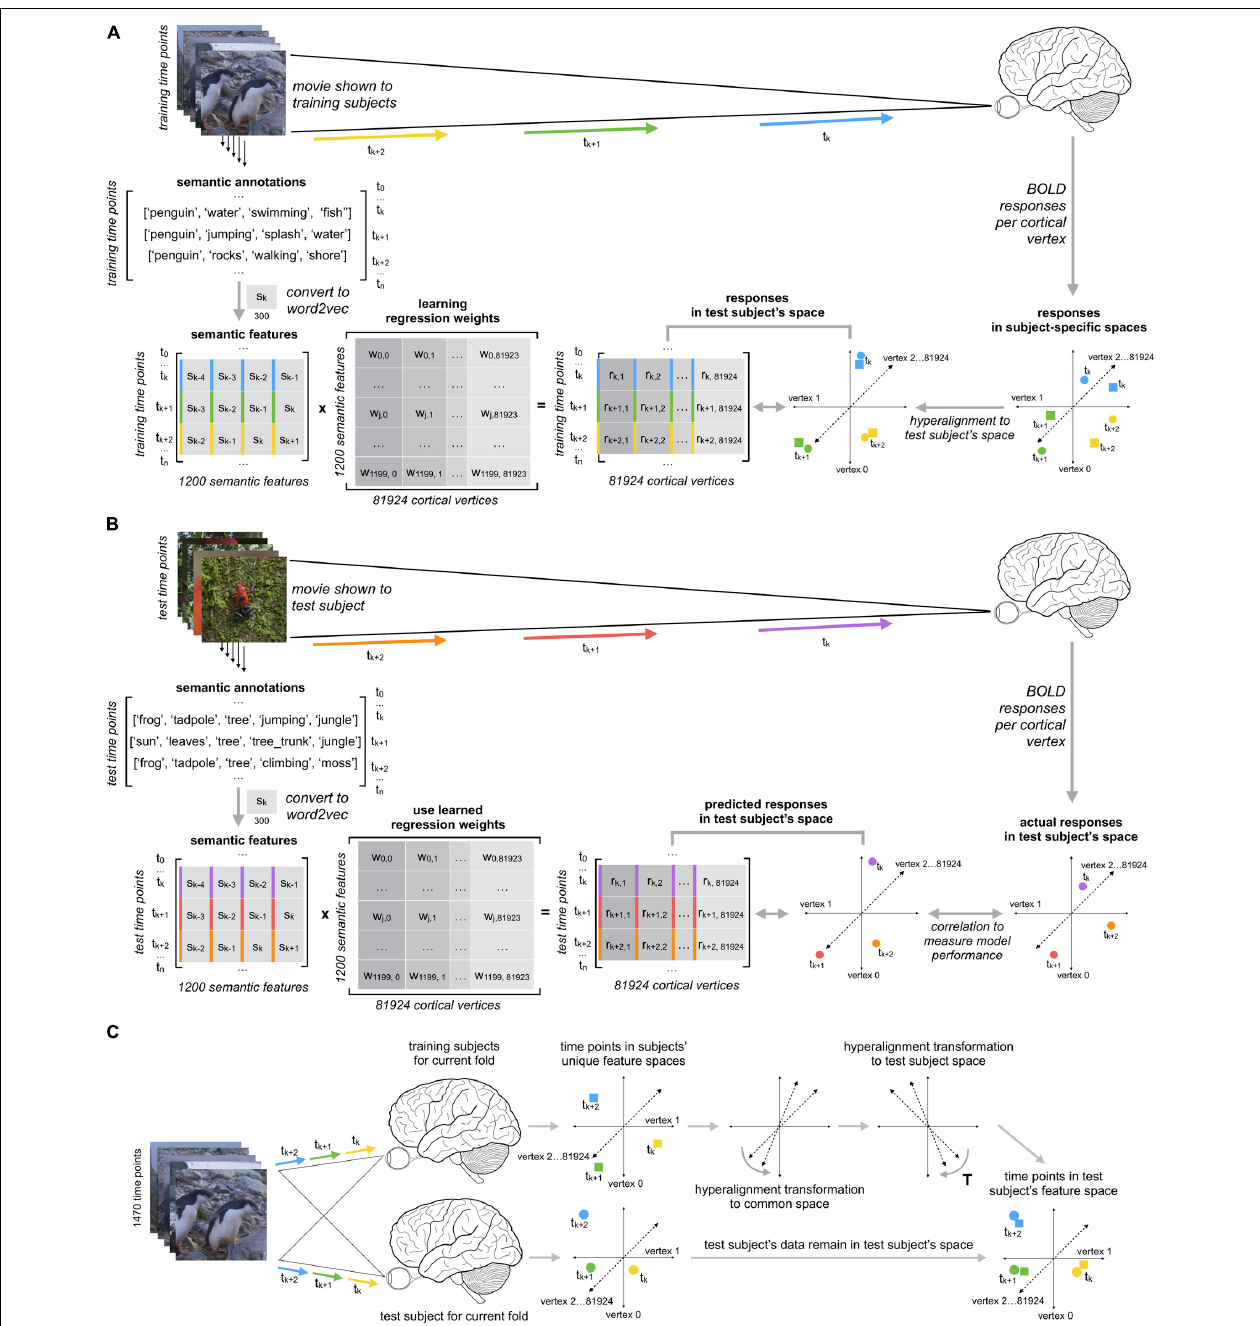
FIGURE 1 | Schematic for constructing between-subject semantic encoding models using hyperalignment. The schematic depicts onefold of the nested leave-one-out cross-validation procedure repeated for 4 test runs and 18 test participants (72 cross-validation folds in total). (A) Training between-subject semantic encoding models using ridge regression. Regression coefficients (weights) are estimated to predict response time series per vertex based on three training runs. (B) Testing semantic encoding models. Regression weights estimated on training data are used to predict response time series for a fourth test run. Model prediction performance is evaluated by computing the Pearson correlation between the predicted responses and are the actual response time series per vertex. (C) Hyperalignment for between-subject semantic encoding models. For each test subject in the leave-one-subject-out cross-validation procedure, we first projected each training subject’s data into the common space using their subject-specific hyperalignment transformations. We then use the transpose of the test subject’s hyperalignment transformation to project all training subjects’ data into the test subject’s space. We averaged response vectors for all training subjects in the test subject’s space, then trained the encoding model on this averaged response trajectory. Finally, we evaluated between-subject model performance by predicting vertex-wise response time series for the left-out test run in the left-out test participant, and computed the Pearson correlation between the predicted time series and the actual time series per